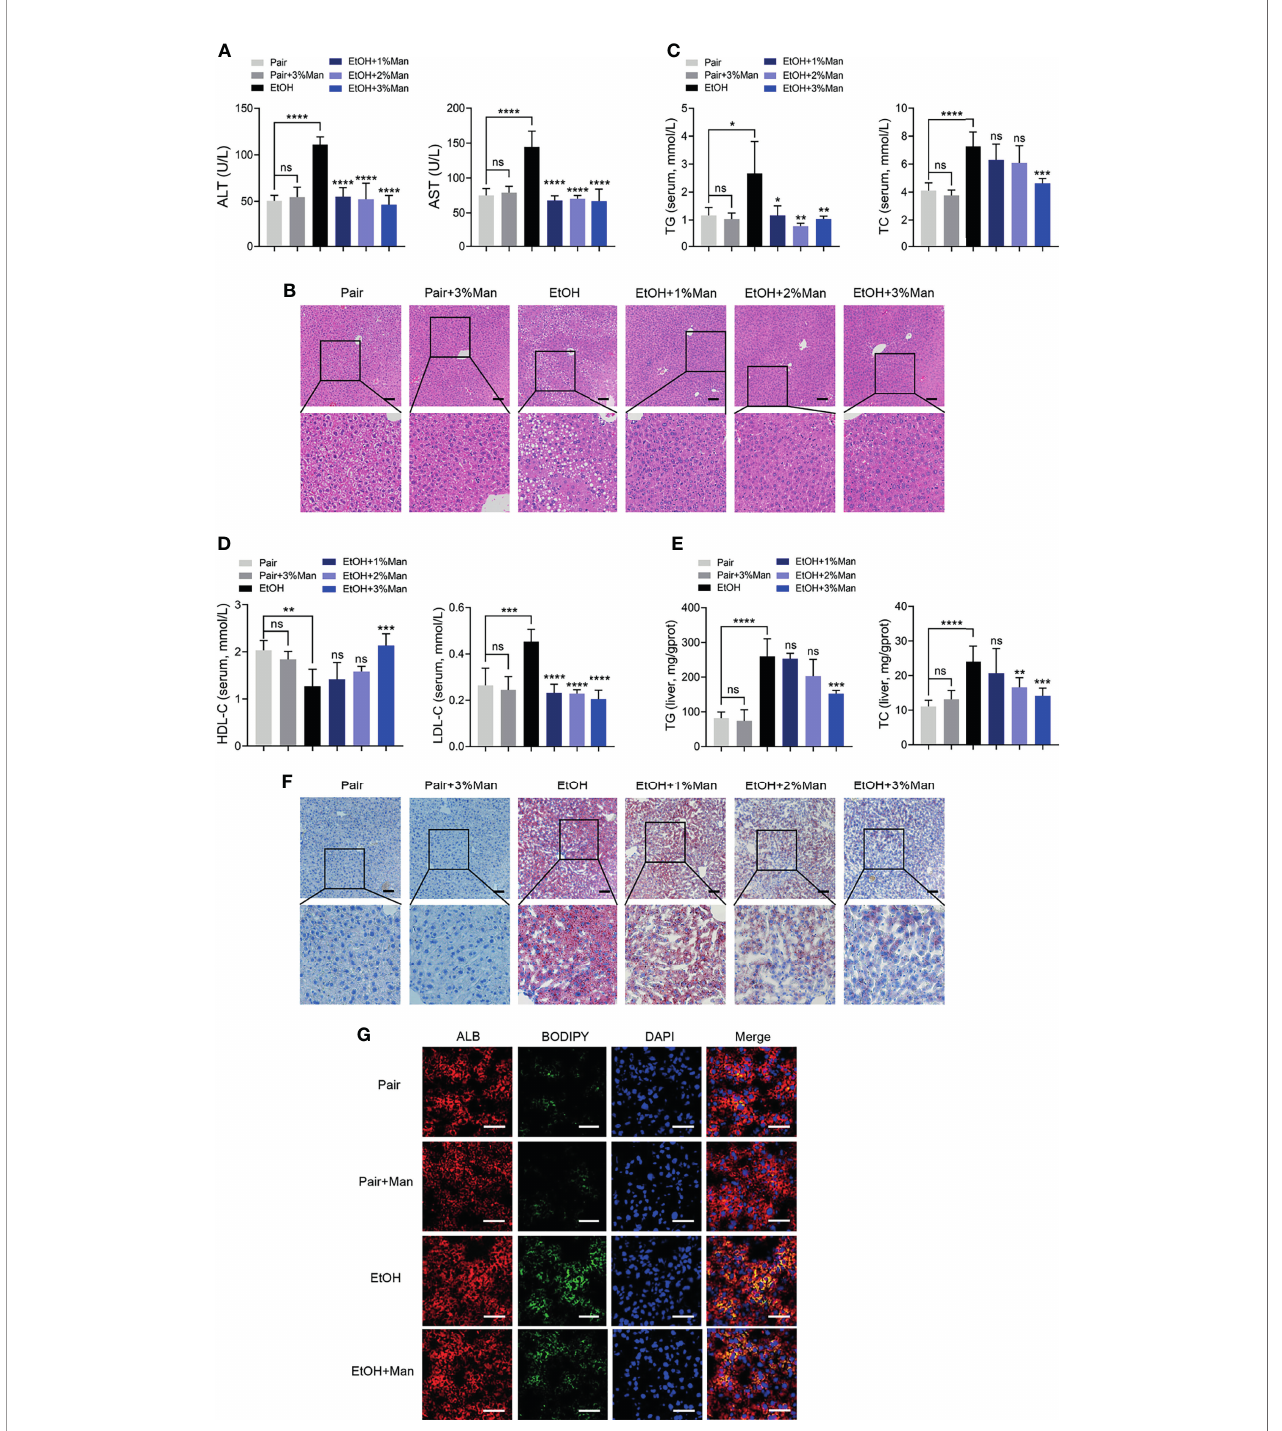
FIGURE 1 | Mannose supplement alleviates hepatic steatosis in ALD. Mice were fed control diet (Pair) or ethanol diet (EtOH) supplemented with/without 1%, 2%, 3% (w/v) mannose (Man) (n = 6 for each group). (A) Serum ALT and AST activities were assessed. (B) Histologic analysis of liver sections using H&E staining. Scale bars = 100 m m. (C, D) Serum TG, TC, HDL-C and LDL-C levels, and (E) hepatic TG and TC contents were determined. (F) Representative images of Oil Red O staining on liver sections. Scale bars = 100 m m. (G) Co-localization of neutral lipids (Green) and hepatocyte markers ALB (Red) in the liver sections were evaluated by immuno fl uorescence staining (n = 3). Scale bars = 25 m m. Data are presented as the means ± SEM and analyzed with the unpaired two-tailed t -test. * p < 0.05, ** p < 0.01, *** p < 0.001, **** p < 0.0001, ns, not signi fi cant, compared with the EtOH